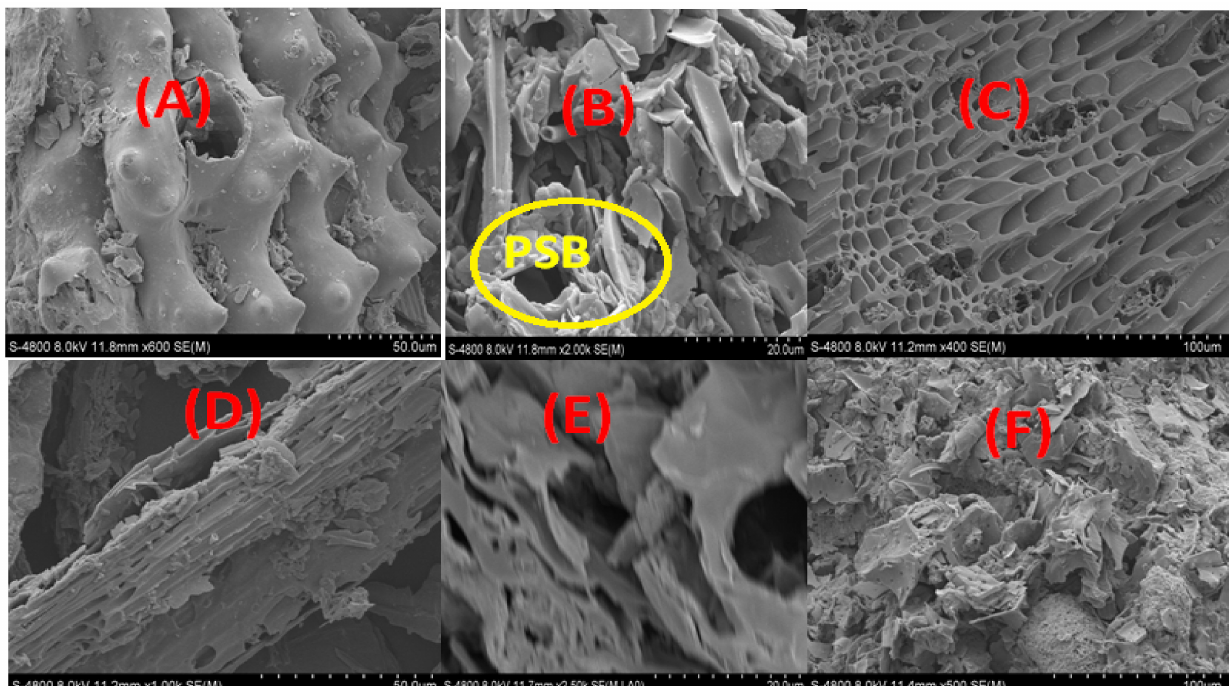
Figure 3. SEM images of carrier materials: ( A ) RHB, ( B ) SSB, ( C ) WB, ( D ) RSB, ( E ) PNB, and ( F ) CCB (unpublished